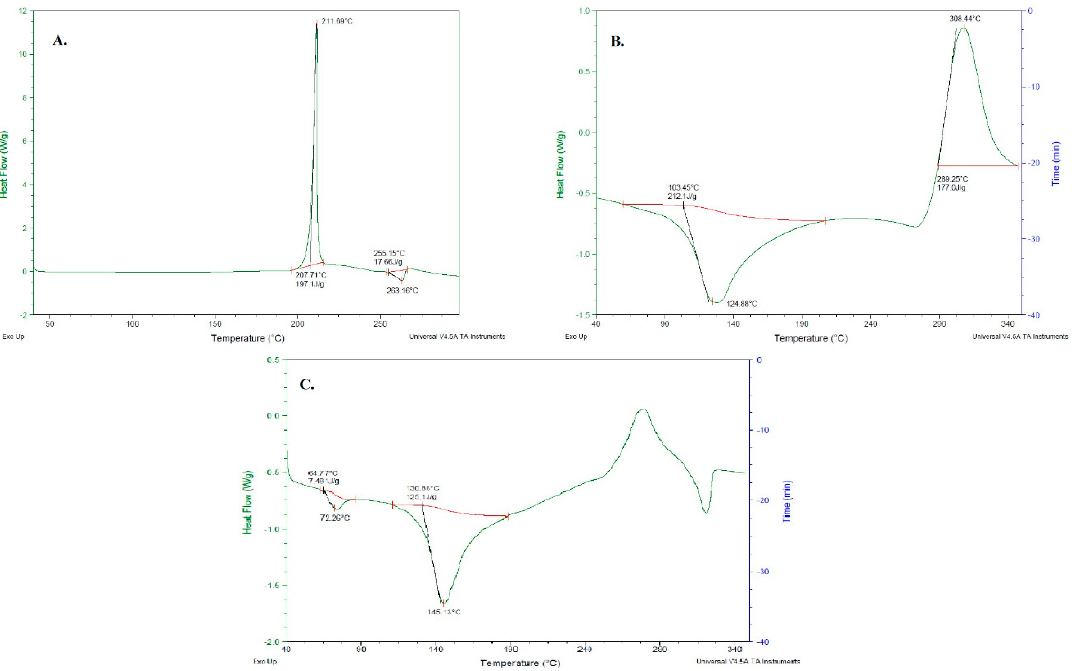
Figure 6. DSC results of ( a ) Ag-FSE, ( b ) CS and ( c ) Ag-FSE